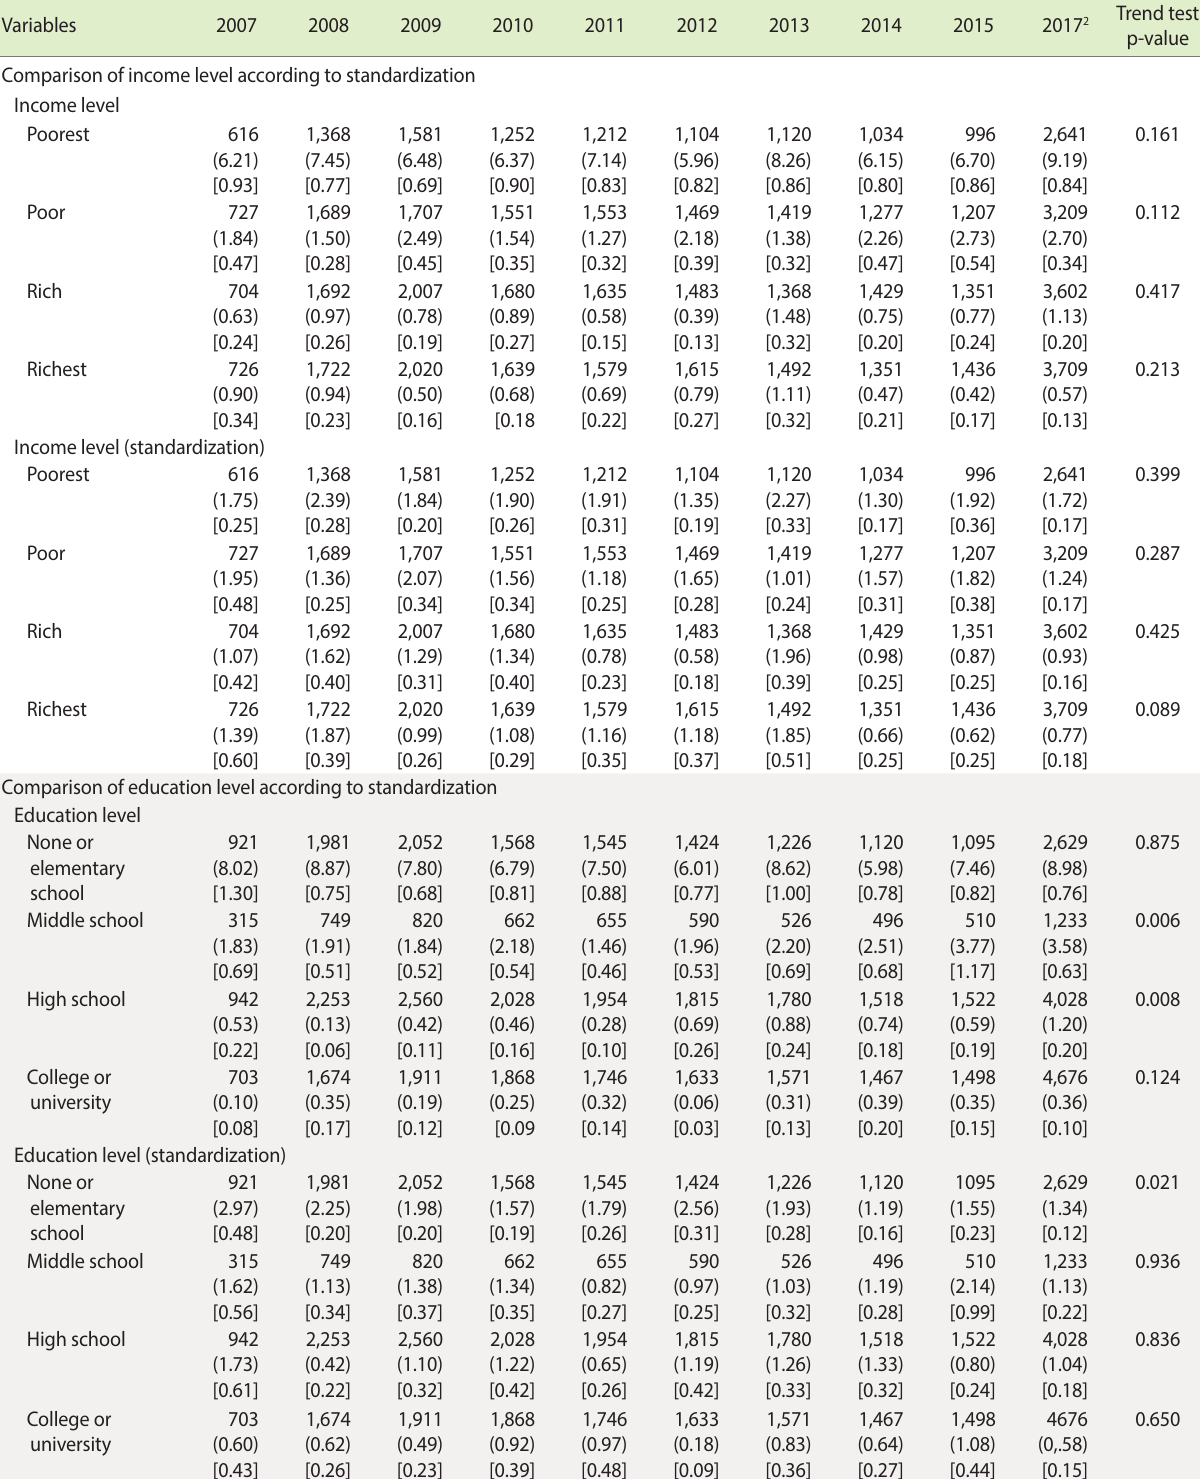
Table 2. Changes in edentulism prevalence 1 according to income level and education